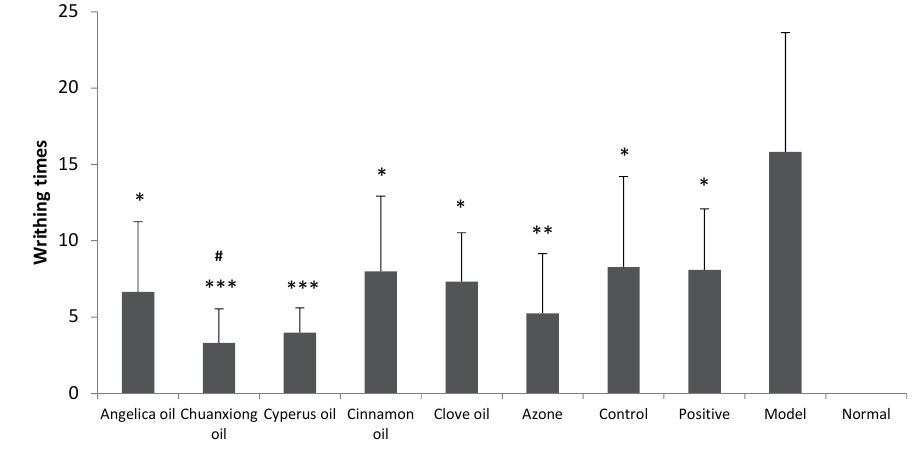
Figure 4. Inhibitory effects of ibu p rofen (140 mg/kg/d) with different EOs on dysmenorrheal model mice’s writhing times (n = 8). Positive: oral administration of 56 mg/kg/d ibuprofen suspension. Control: transdermal administration of ibuprofen hydrogel without PE. * p < 0.05, ** p < 0.01, *** p < 0.001 vs. the model group. # p < 0.05 vs. the control